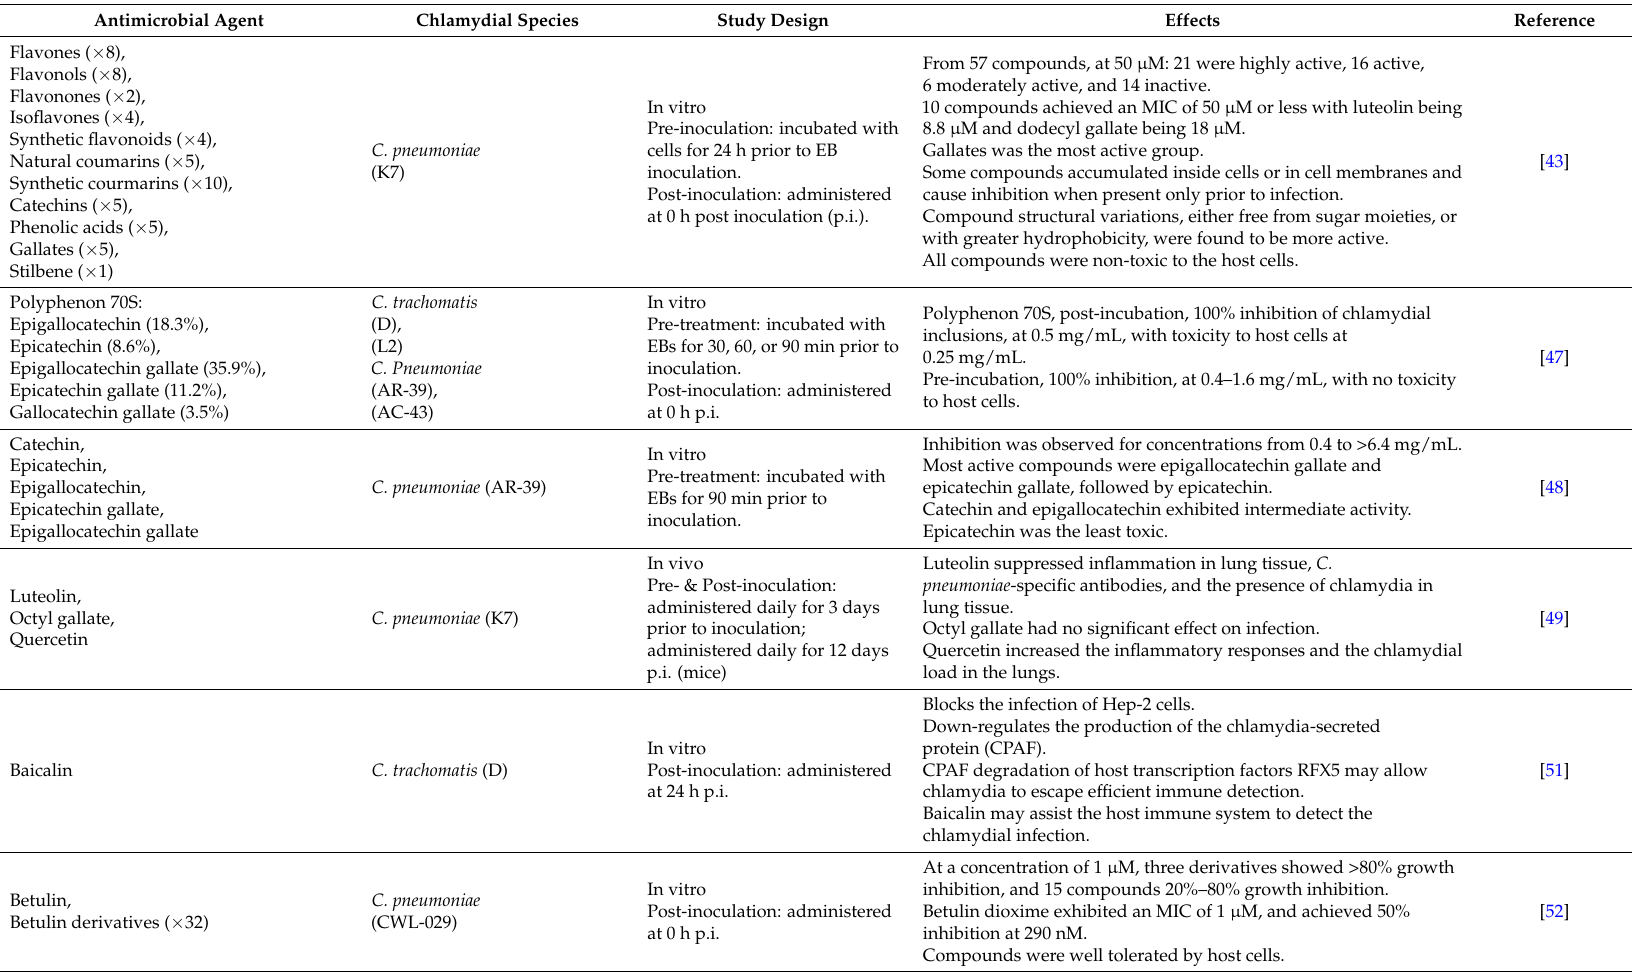
Table 2. Past studies exploring antichlamydial properties of polyphenolic